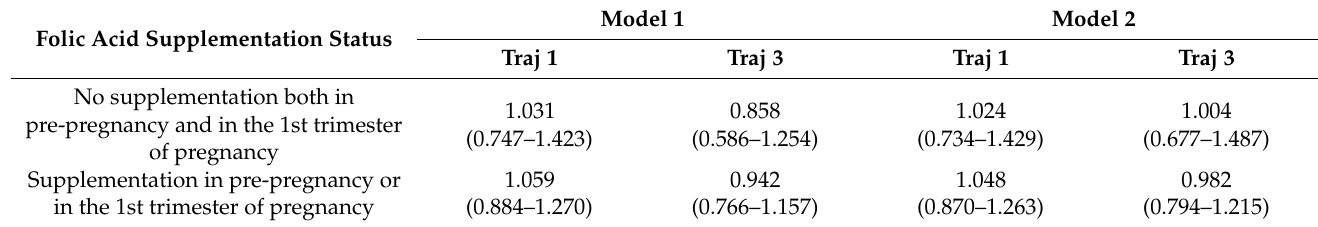
Table 4. Association of peri-conceptional folic acid supplementation status with head circumference-